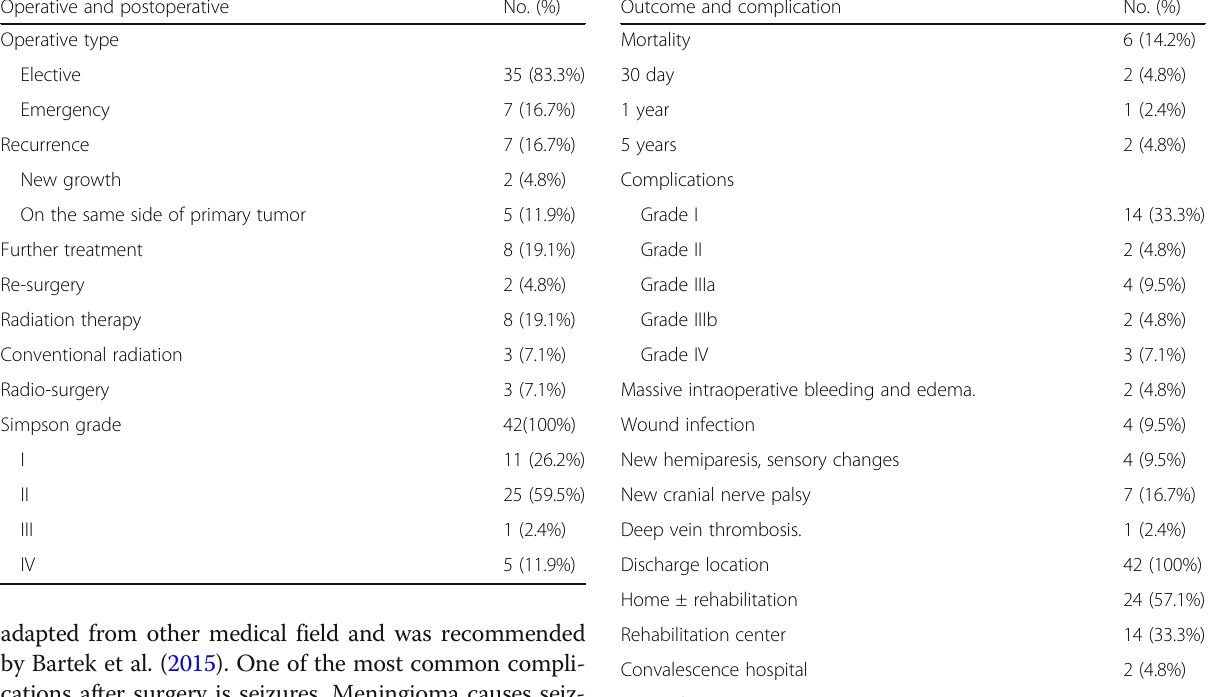
Table 2 Operative and postoperative Operative and postoperative